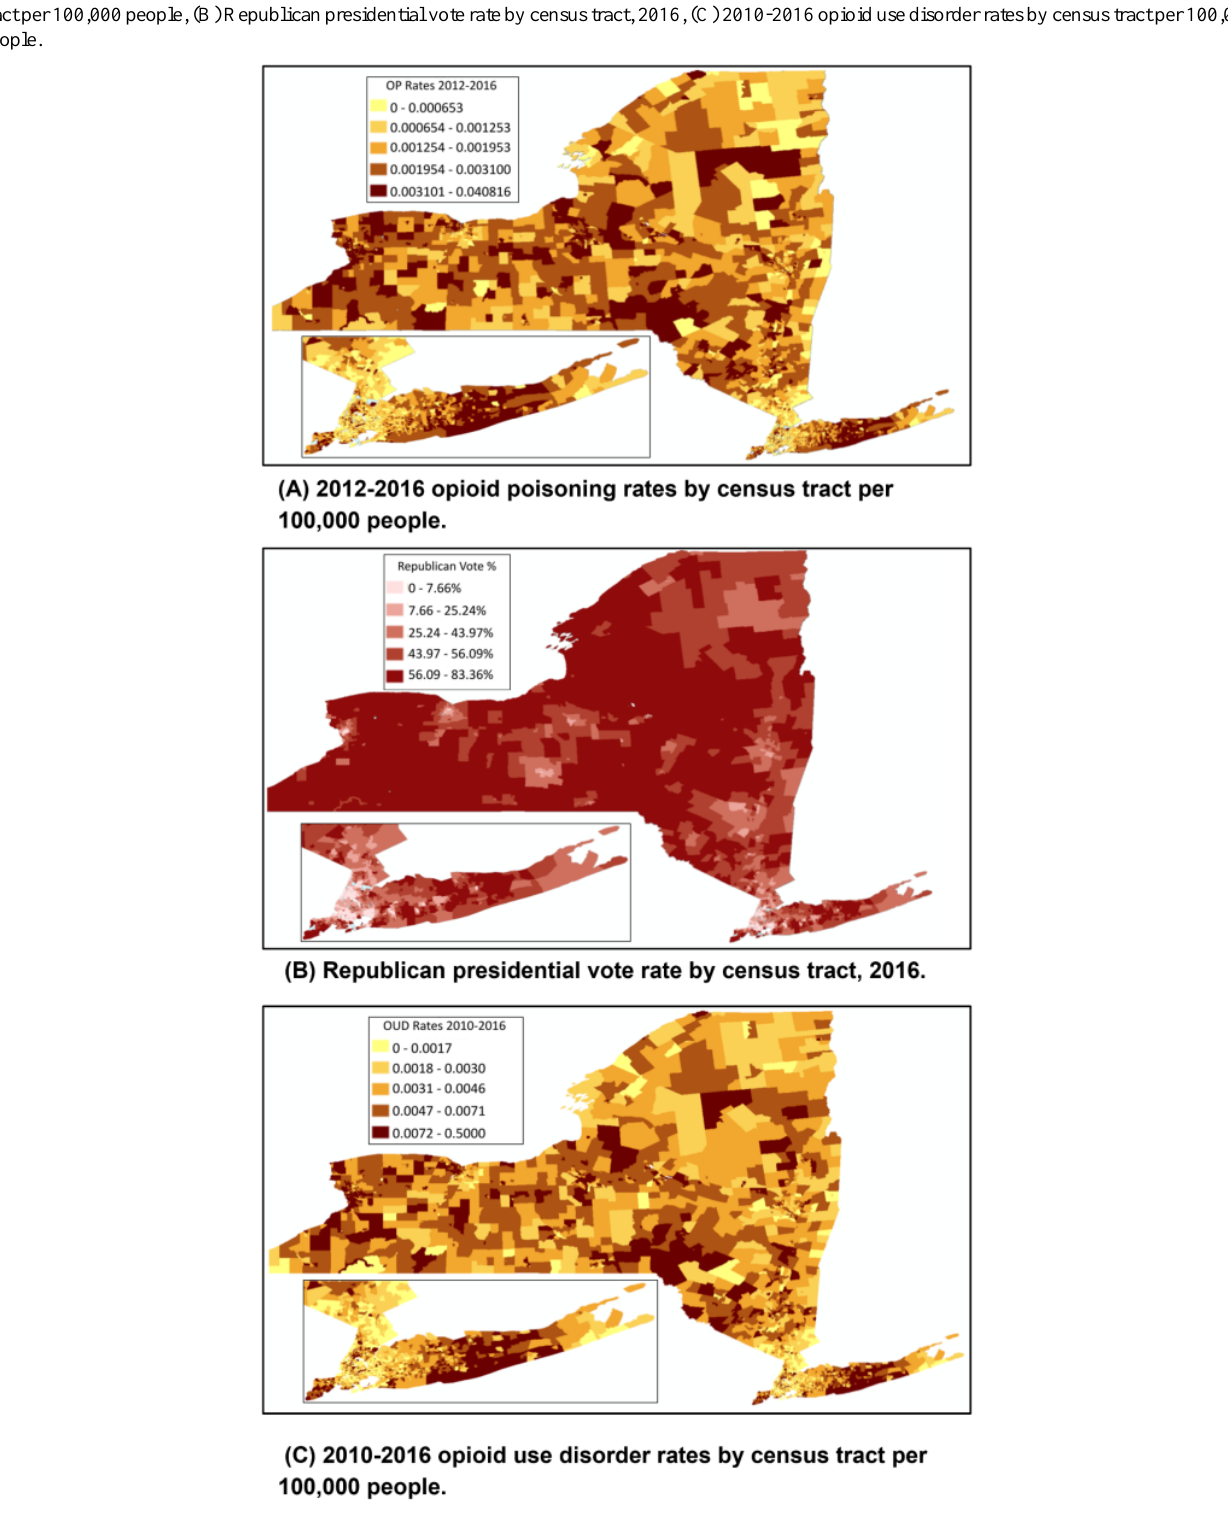
Figure 1. Opioid use and Republican presidential vote 2016 in New York State at census tract level: (A) 2012-2016 opioid poisoning rates by census tract per 100,000 people, (B) Republican presidential vote rate by census tract, 2016, (C) 2010-2016 opioid use disorder rates by census tract per 100,000